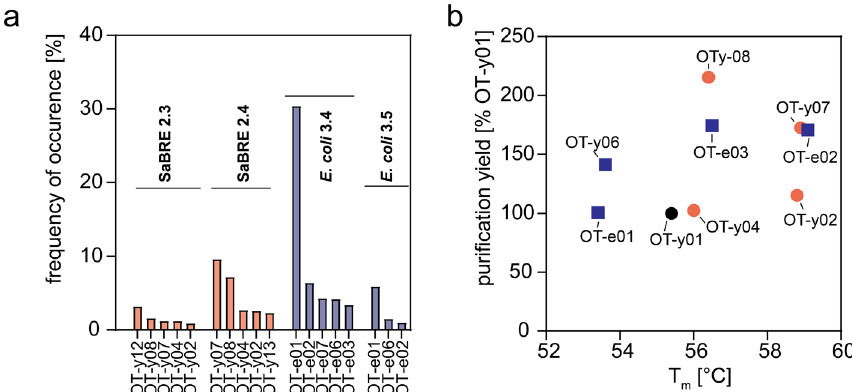
Figure 5. Characterization of most enriched single clones. ( a ) Occurrence of the most enriched variants of all four pools sequenced as determined by NGS. Variants identified in SaBRE pools (OT-yXX) are coloured in salmon, and variants identified in pools enriched during E. coli -based selection (OT-eXX) are coloured blue. Sequences were numbered according to their occurrence in initial Sanger sequencing results. ( b ) The purification yield of OTR purified from HEK293 cells, normalised to OT-y01, is compared to the apparent T m derived from CPM-based thermostability